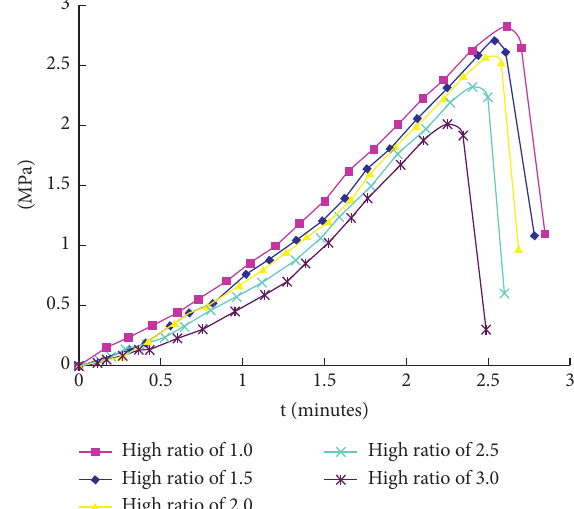
Figure 10: Stress-strain curves of five different height-to-diameter